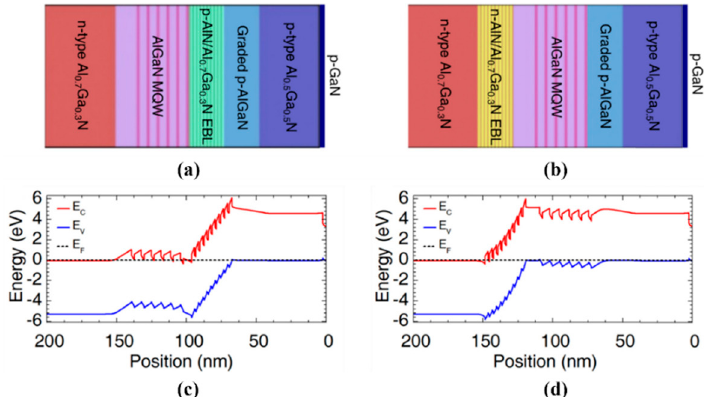
Figure 4. Schematic of the DUV LEDs with ( a ) p-AlN/AlGaN superlattice EBL and ( b ) n-AlN/AlGaN superlattice EBL. Energy band diagram for the DUV LEDs with ( c ) p-AlN/AlGaN superlattice EBL and ( d ) n-AlN/AlGaN superlattice EBL. Reproduced from Ref. [64] with permission from the Optical Society of America.